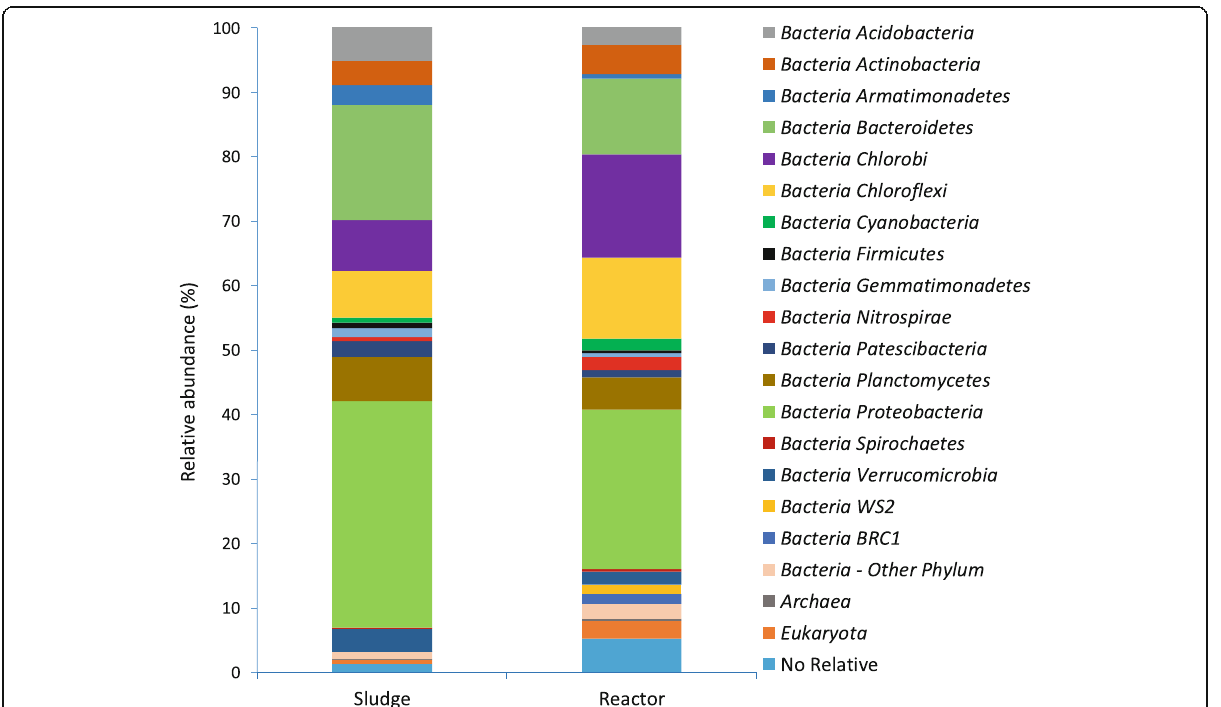
Fig. 3 Percentage of the relative abundant of major bacterial phyla, Archaea, and Eukaryotic organisms in the sludge seed and in the upflow